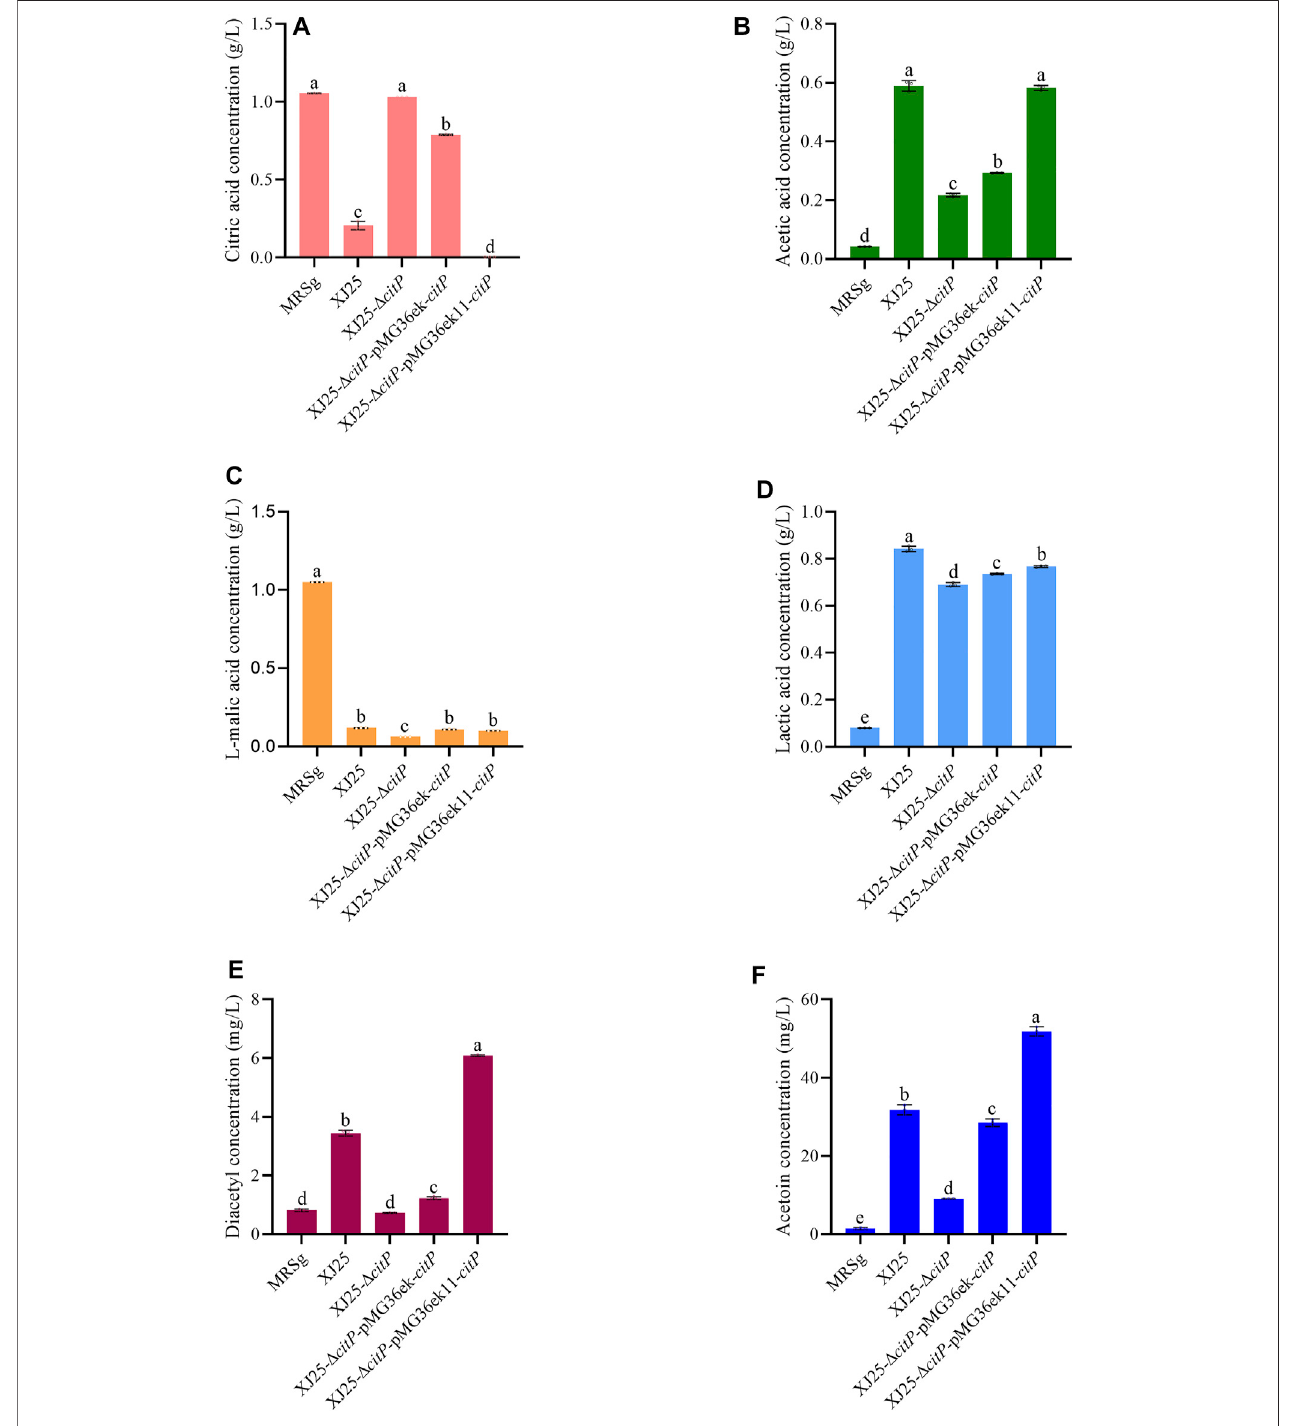
FIGURE 2 | Changes in metabolite concentration in the MRSg medium after 24 h culture with the wild-type and the mutants (A) citric acid, (B) acetic acid, (C) L-malic acid, (D) lactic acid, (E) diacetyl and (F) acetoin. Data are expressed as mean ± standard deviation and ( n = 3). a-e means with different lower-case letters in the same row indicate signi fi cant differences ( p <